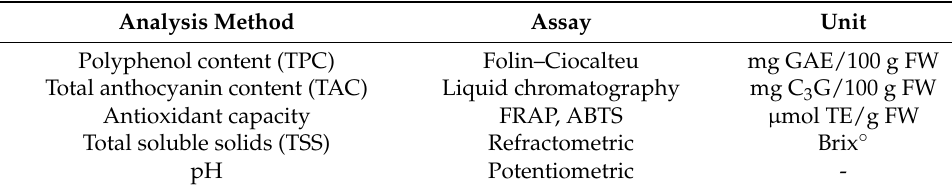
Table 1. Summary of analysis